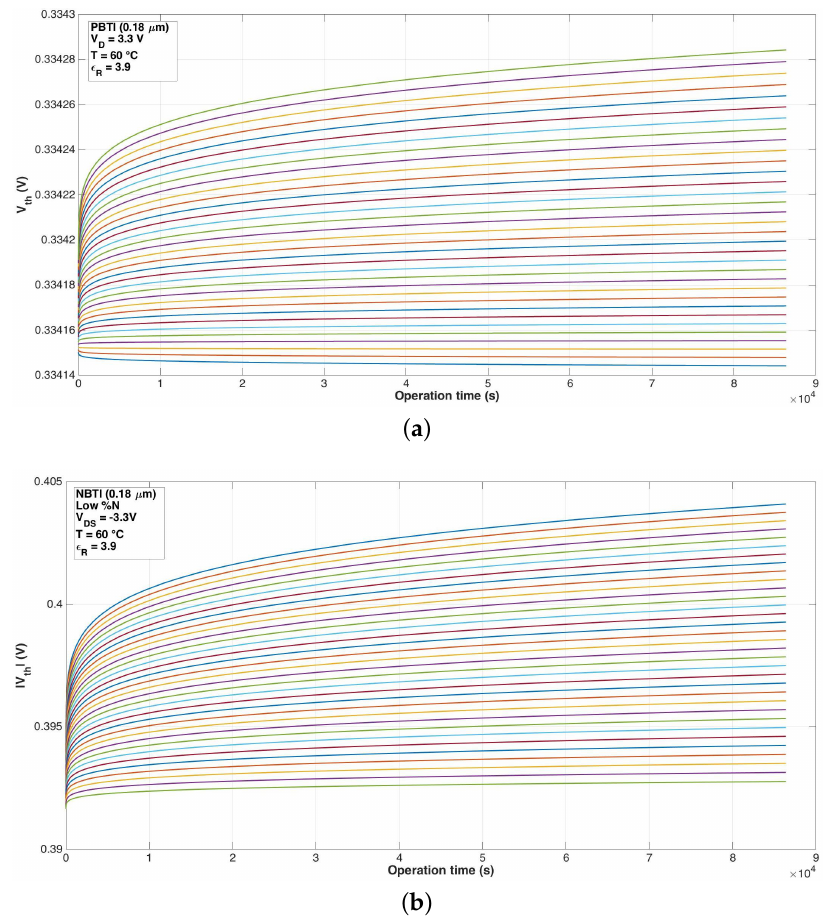
Figure 15. Threshold voltage degradation results for ( a ) nMOS and ( b ) pMOS devices for less than 24